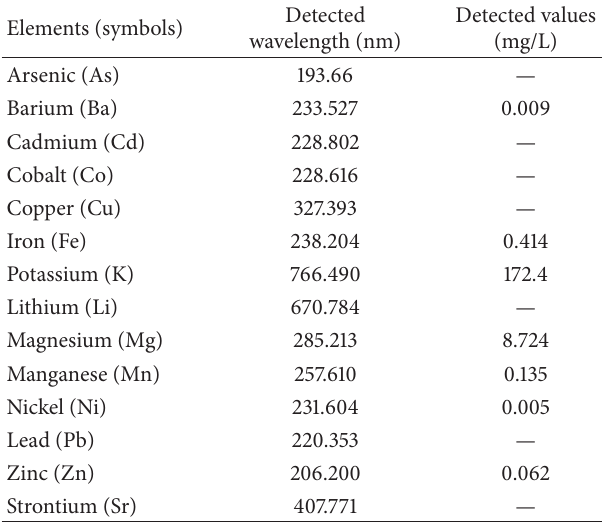
Table 1: Inductively coupled plasma (ICP) based elemental analysis of Emblica officinalis dried